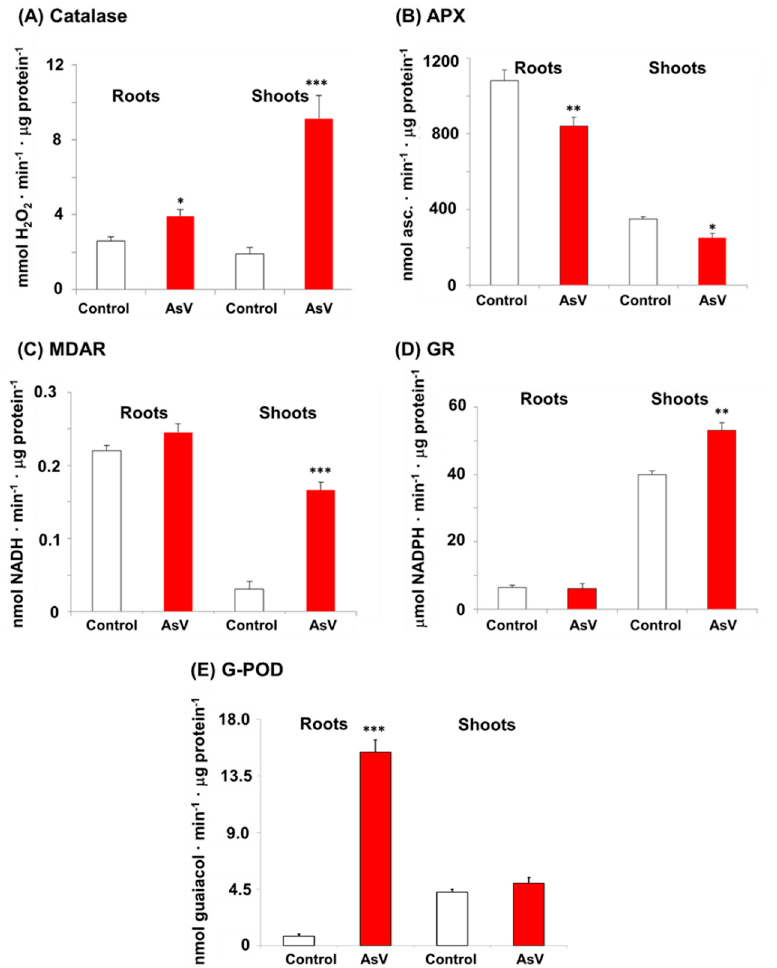
Figure 5. Activity of diverse antioxidant enzymes in roots and shoots of 26-d-old rice seedlings grown in hydroponic solutions supplemented the last 12 days without (control) and with 50 µ M AsV. ( A ) Catalase. ( B ) APX, ascorbate peroxidase. ( C ) MDAR, monodehydroascorbate reductase. ( D ) GR, glutathione reductase. ( E ) G-POD, guaiacol peroxidase. Data are means ± SEM of at least three independent experiments. t-Student was used to compare data from As-treated plants with control ones. Asterisks indicate that di ff erences with respect to control (0 µ M AsV) values were statistically significant at p < 0.05 (*), p < 0.01 (**) and p < 0.001 (***).